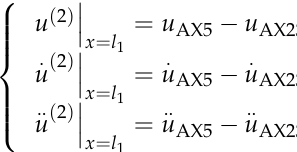
Amplitude-frequency curves of relative acceleration of soil and pile are shown in Figure 16, respectively. Furthermore, the working condition of Figure 16a is S5, and Figure 16b is S10. The frequency of relative motions of two groups are not the same on the S5 condition, namely motion states of the system cannot keep coordinated; in contrast, the frequency of relative motions of two groups are the same on the S10 condition, and motion states coordinate well.